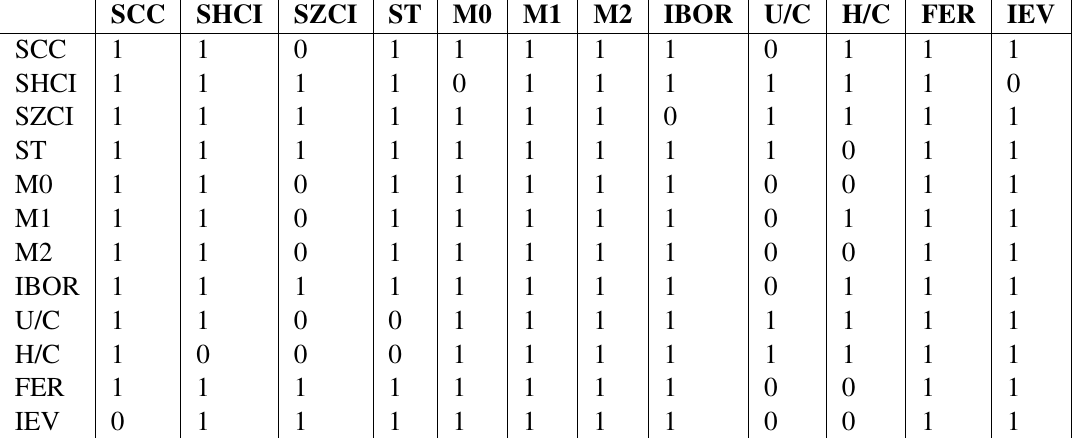
Table 3 Causal relationship matrix between 12 decision